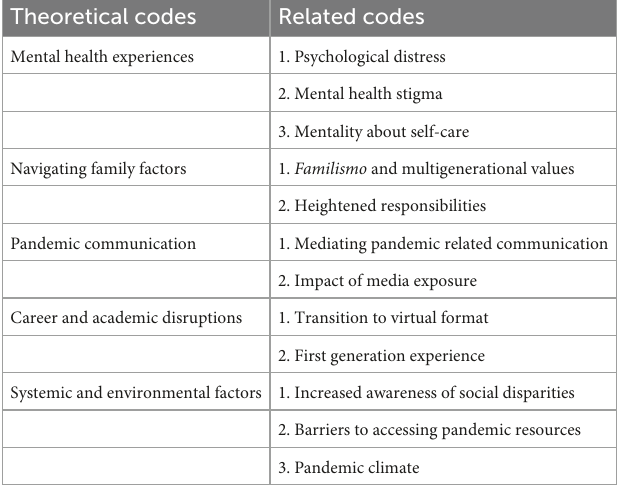
TABLE 2 Theoretical codes and related